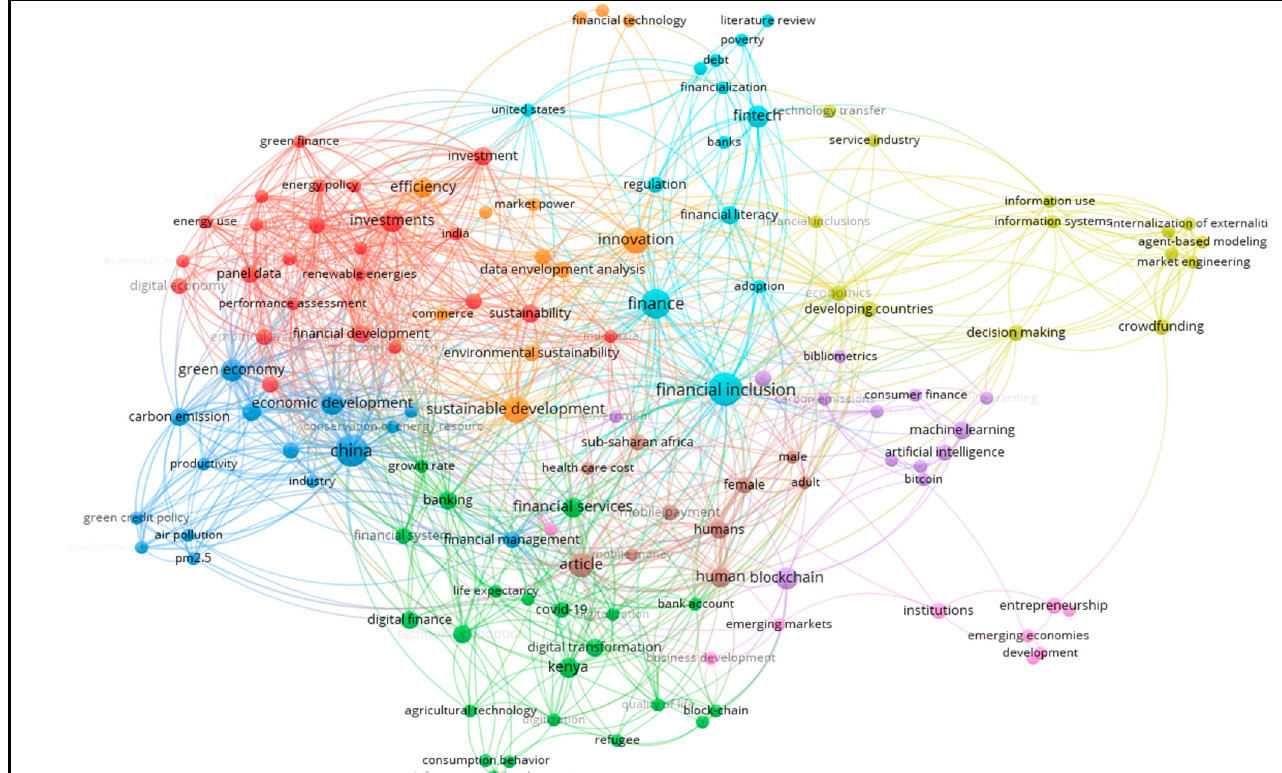
Figure 6. Network of the co-occurrence of keywords. Source: Authors’ own compilation processed on VOSViewer.